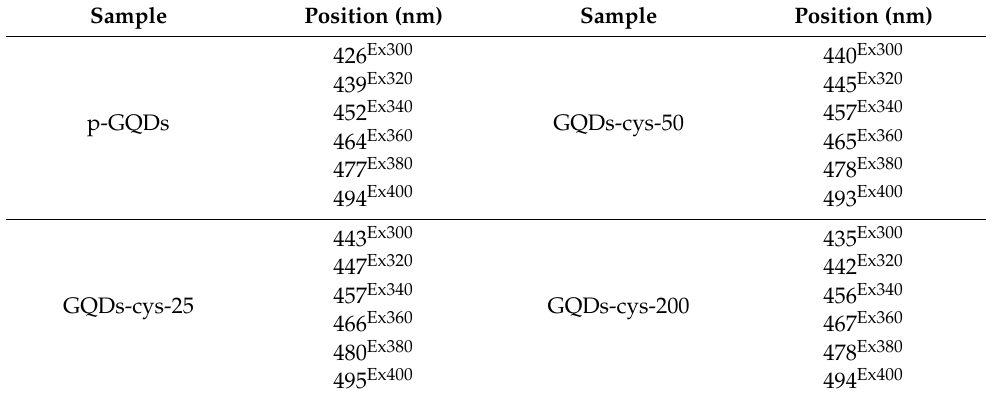
Table 1. Positions of the emission band center in nm at excitation wavelength from 300 to 400 nm.